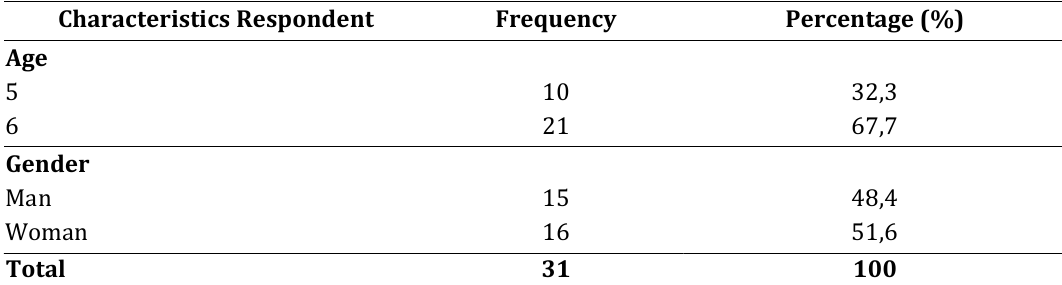
Characteristics Distribution of Respondents of Fine Motor Development in Srikandi Kindergarten Lhokseumawe